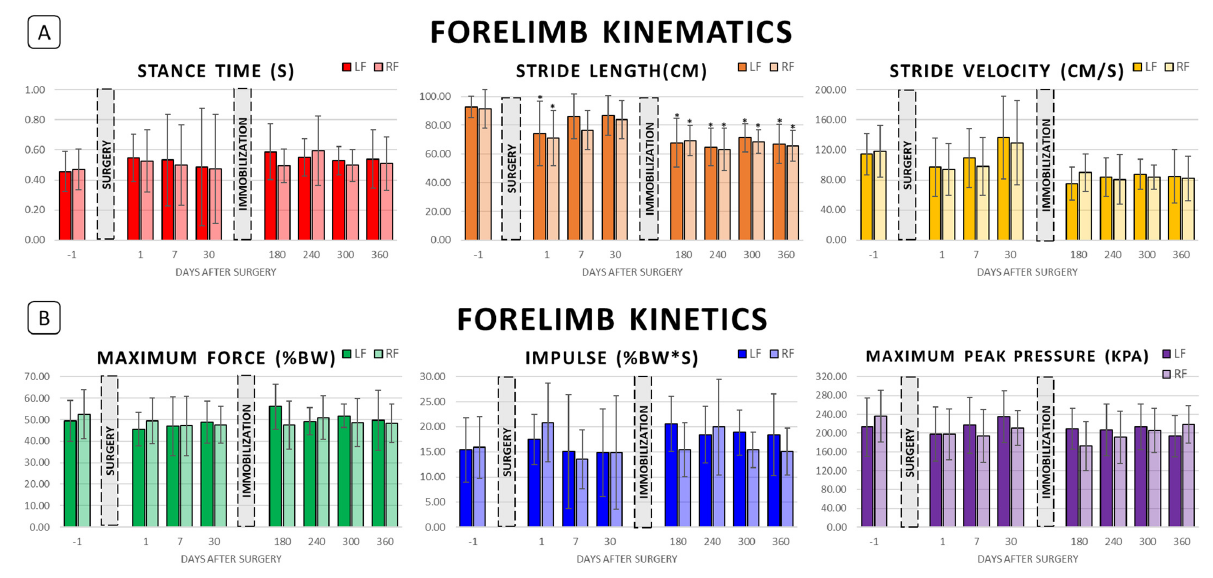
Figure 2. Forelimb biomechanics following right hindlimb tibial segmental defect locking plate stabilization and following right hindlimb cast immobilization. ( A ) Forelimb kinematics preoperatively (Day − 1) and postoperatively at Days 1, 7, 30, 180, 240, 300, and 360. ( B ) Forelimb kinetics at the same timepoints. “*” represents value significantly different from the respective preoperative baseline in pairwise comparison; p < 0.05.